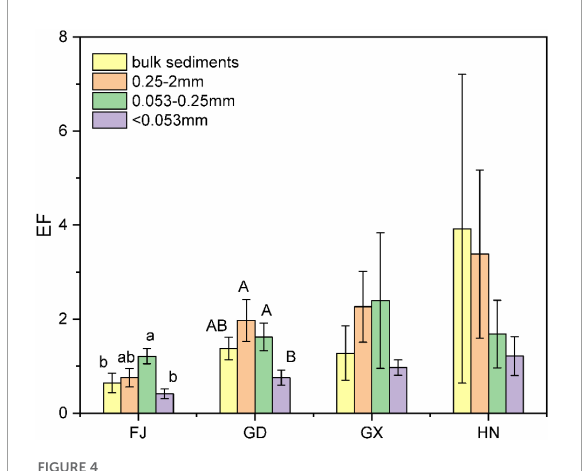
FIGURE4 Enrichment factors (EF) for black carbon in sediment fractions from different mangrove wetlands in China. Different lowercase and uppercase letters indicate significant differences ( α = 0.05) in the samples from Fujian (FJ) and Guangdong (GD), respectively. GX, Guangxi; HN,